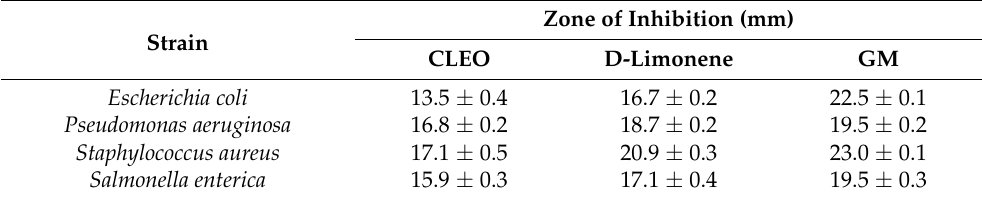
Table 4. Bactericidal efficacy of the Citrus limetta (CLEO) essential oil, D-Limonene, and gentamicin (GM) by disc diffusion assay in MHA plates.